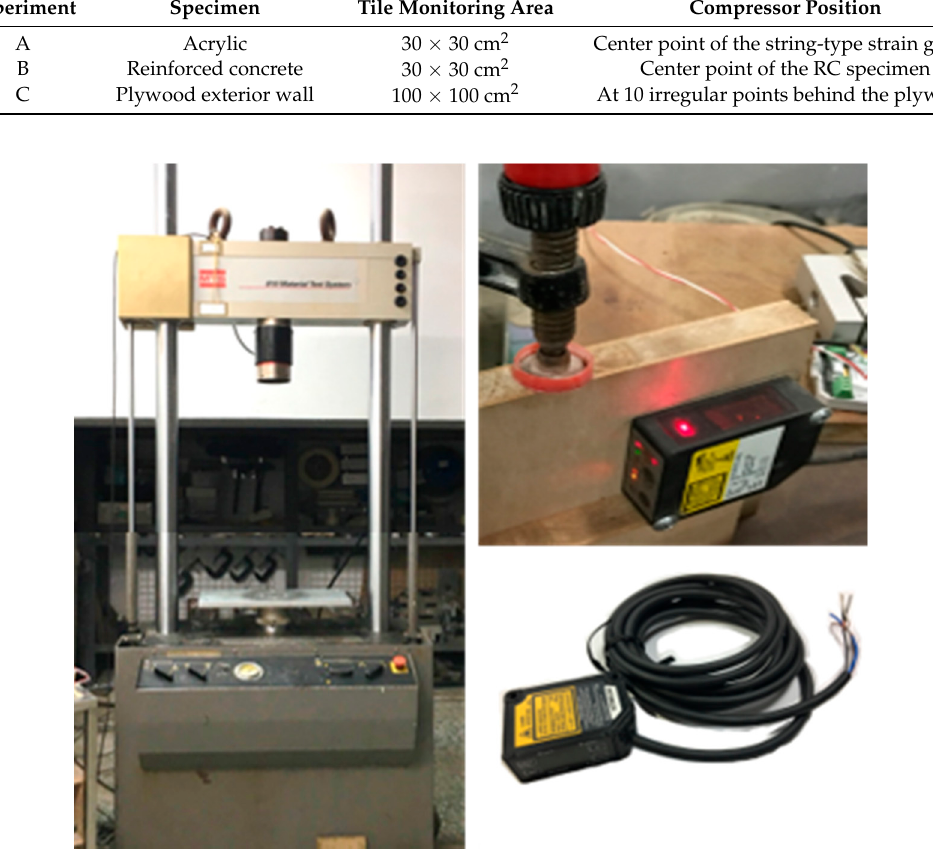
Figure 4. MTS and laser displacement sensor.